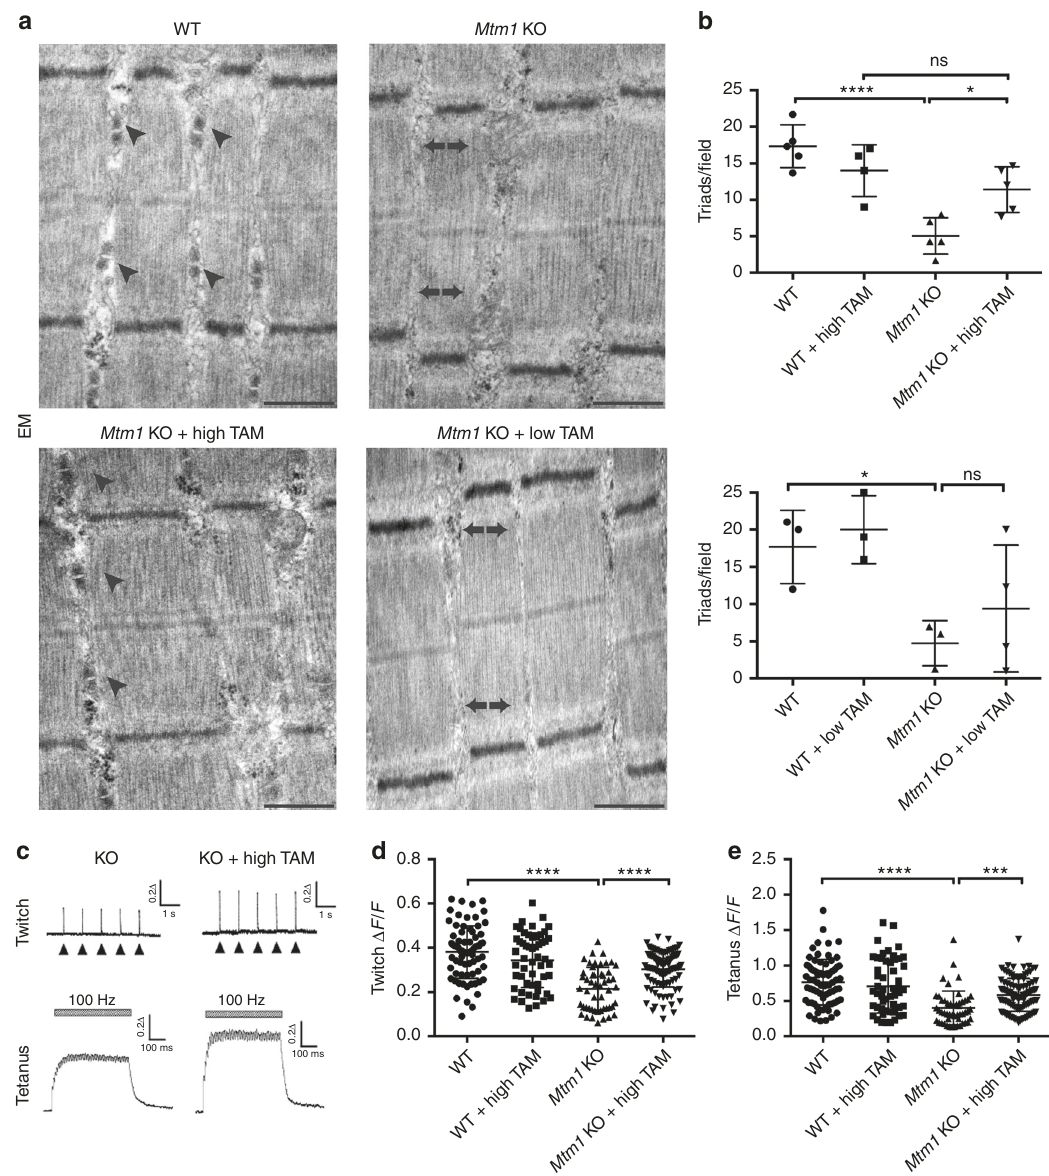
Fig. 4 Tamoxifen treatment restores triad structure and function in Mtm1 KO mice. a Electron microscopy reveals normal triad structure in WT (arrowheads), reduction of triads in Mtm1 KOs (arrows), and restoration of triads in high-dose TAM treated KOs (arrowheads). Triad number was not improved in low-dose TAM treated KOs (arrows). b Quanti fi cation of triad number per fi eld for WT = 17 ± 2 ( n = 5), KO = 5 ± 1.5 ( n = 5, **** p <0.0001 compared to WT), high-dose TAM treated WT = 14 ± 2 ( n = 4), and high-dose TAM treated KOs = 11 ± 2 ( n = 5, * p = 0.03 vs. KOs and non- signi fi cant vs. WT + TAM). Triad number for low-dose TAM treated KOs = 9.4 ± 5 ( n = 4), untreated KOs = 4.8 ± 3 ( n = 3, * p < 0.05 compared to WT), WT = 18 ± 5 ( n = 3) and WT + low-dose TAM = 20 ± 5 ( n = 3). c Calciumtransients are increased in dissociated muscle fi bers from Mtm1 KO mice treated with high-dose TAM in response to electrically evoked twitch and tetanus stimulation. Representative Mag-Fluo-4 fl uorescence traces of FDB fi bers during fi ve successive single electrically evoked (Twitch) stimuli and Tetanus (500 ms at 100 Hz) stimulation from either Mtm1 KO, or KO treated with high-dose TAM. d Twitch stimulation is signi fi cantly reduced in Mtm1 KOs (0.21 ± 0.01, n = 51 fi bers, **** p < 0.0001 vs. WT = 0.38 ± 0.08, n = 73 fi bers) and improved with high-dose TAM (0.30 ± 0.01, n = 102 fi bers, **** p < 0.0001 vs. KO). e Tetanus stimulation is signi fi cantly reduced in KOs compared to WT and improved with high-dose TAM (KO + TAM = 0.60 ± 0.03, n = 103 fi bers, *** p < 0.001 vs. untreated KO = 0.40 ± 0.05, n = 51 fi bers, **** p < 0.0001 vs. WT = 0.8 ± 0.04, n = 73 fi bers, and vs. WT + TAM = 0.70 ± 0.05, n = 53 fi bers). Statistical analyses were conducted by two-way ANOVA, followed by Tukey ’ s multiple comparisons post-test or Fisher ’ s least common differences post-test. For direct two sample comparisons, unpaired, parametric two-tailed Student's t -test was performed. Scale bars = 500 Tamoxifen reduces DNM2 levels in vivo and in vitro . DNM2 tamoxifen therapy at either low or high-dose signi fi cantly reduced DNM2 protein levels in MTM skeletal muscle protein levels (but not transcript levels) are elevated in Mtm1 (Fig. 8a – f), and high-dose therapy reduced levels in wild-type KO mice and lowering these levels ameliorates most aspects of mice as well (Fig. 8a – e). Estradiol, but not fulvestrant, also the MTM mouse phenotype 9,26,28 . Thus, we quanti fi ed DNM2 levels in the context of tamoxifen treatment. Importantly, reduced DNM2 protein levels in MTM mice, though not to